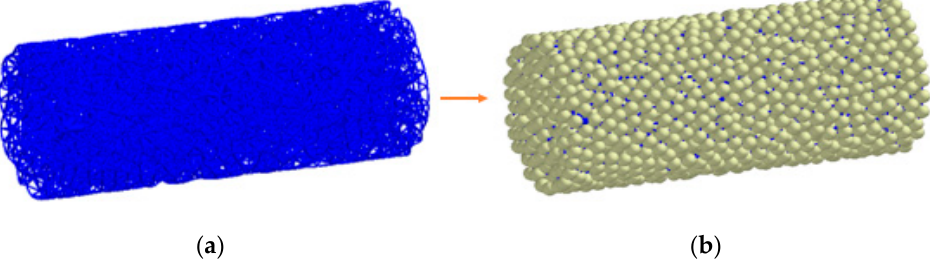
Figure 5. The cylindrical sample model bonded by small particles: ( a ) bonds formed be- tween particles, ( b ) cylindrical samples model with bonds. Table 2. The bond parameters of the walnut kernel bending failure simulation model.